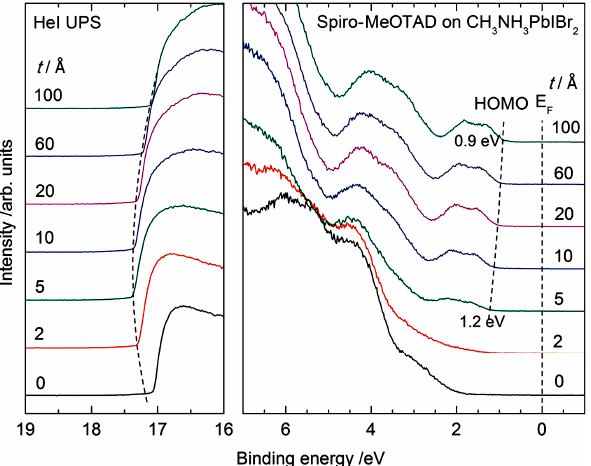
Figure 9. Thickness ( t ) dependence of UPS spectra of spiro-MeOTAD on MAPbIBr 2 . The left panel displays the SECO region and the right panel displays the HOMO region, respectively [94]. Copyright